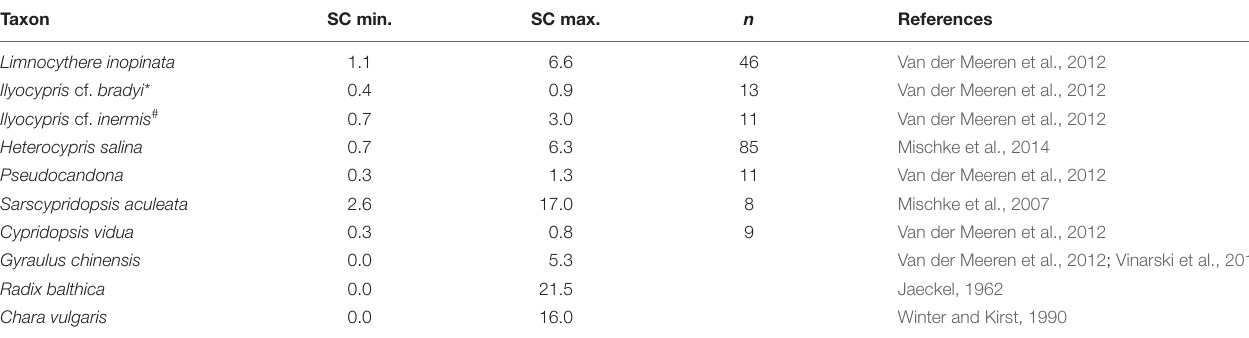
TABLE 1 | Published specific conductivity (SC) tolerance ranges (minima and maxima) for taxa recorded in the sediments of Lake Ulaan. Taxon SC min. SC max.